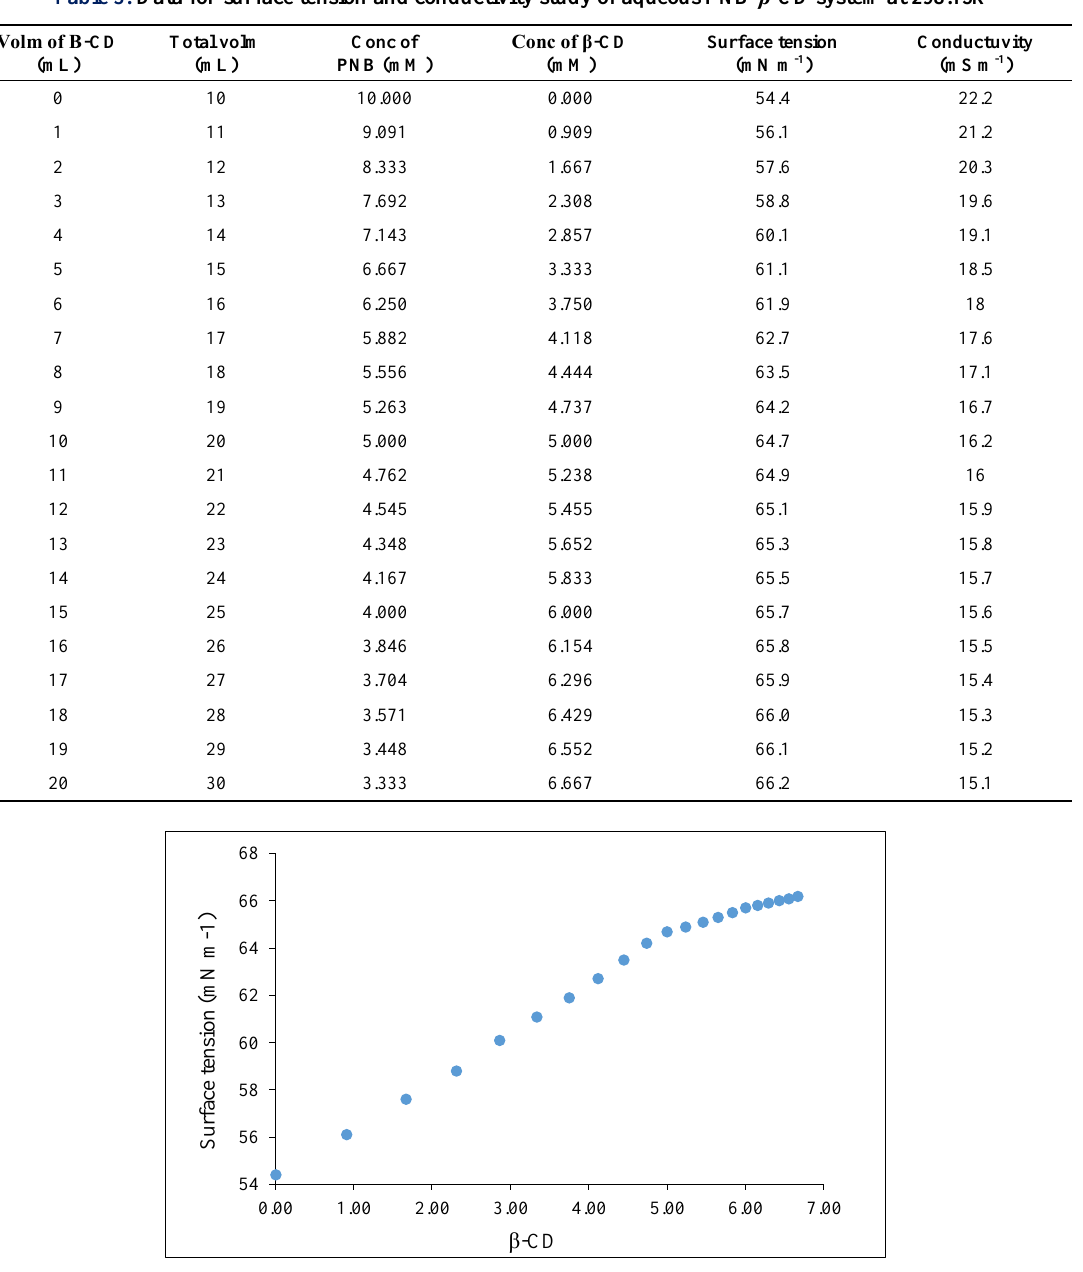
Table 3. Data for surface tension and conductivity study of aqueous PNB- β -CD system at 298.15K a